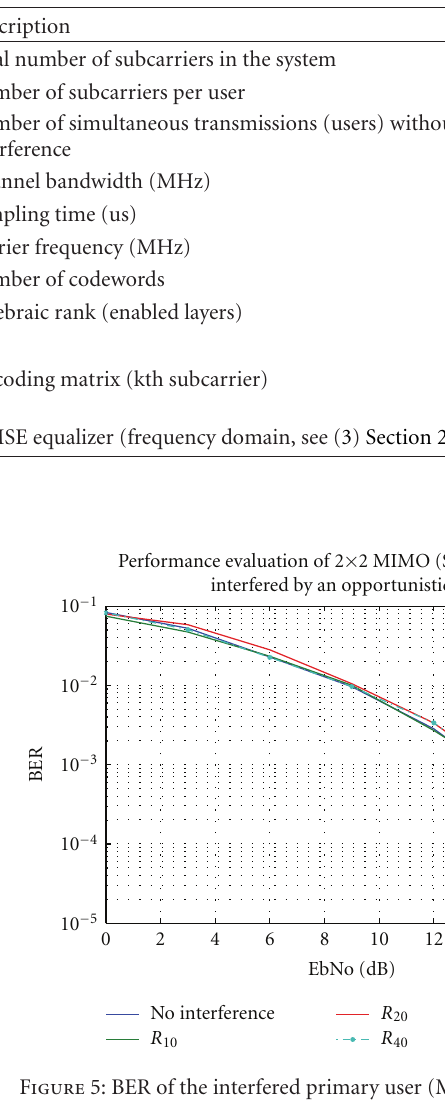
way, the CDF was determined as can be appreciated in Figure